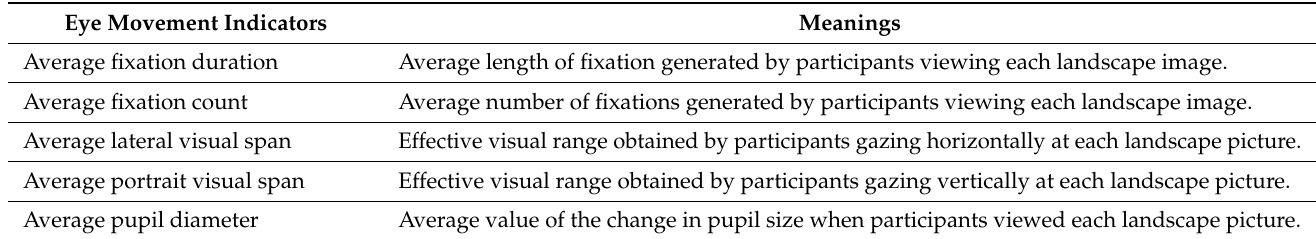
Table 1. Eye movement indicators and meanings. Eye Movement Indicators Meanings Average fixation duration Average fixation count Average lateral visual span Average portrait visual span Average pupil